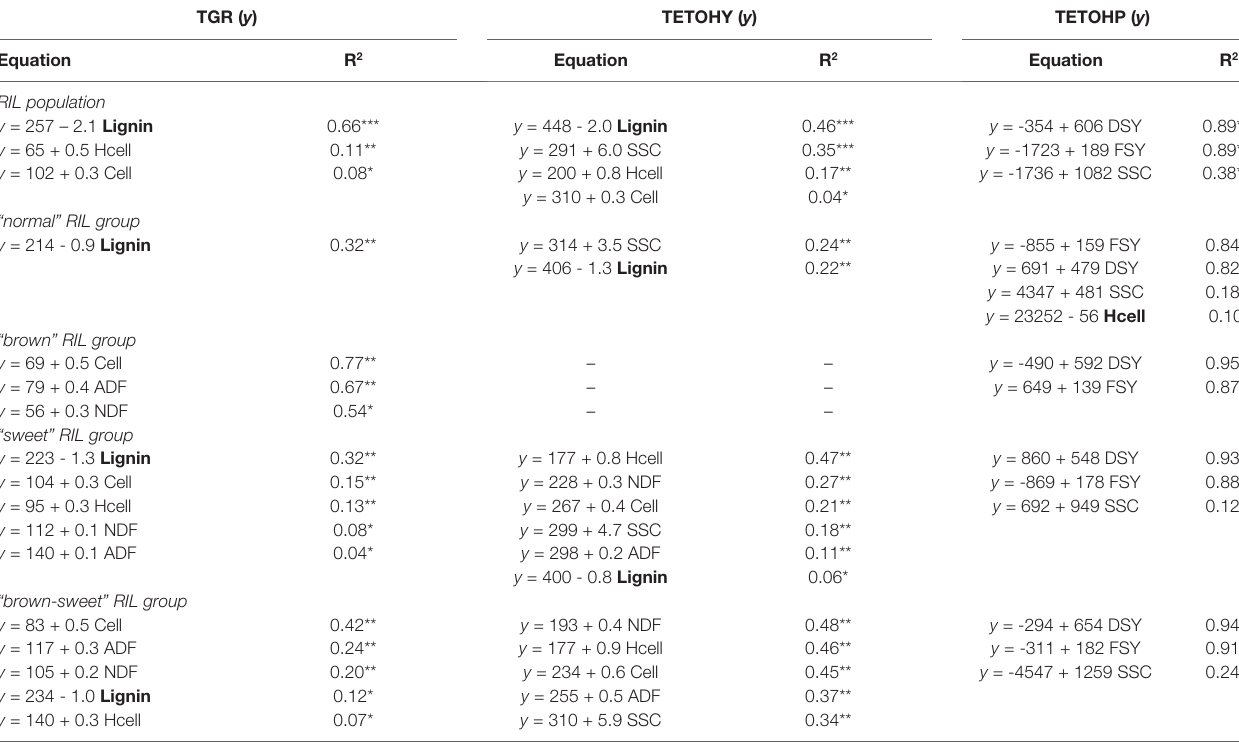
TABLE 4 | Prediction estimates for theoretical glucose recovery (TGR), theoretical ethanol yield (TETOHY), and theoretical ethanol production (TETOHP) in the entire RIL population as well as the contrasting phenotypic groups. TGR ( y ) TETOHY ( y ) TETOHP ( y ) Equation R 2 Equation R 2 Equation R